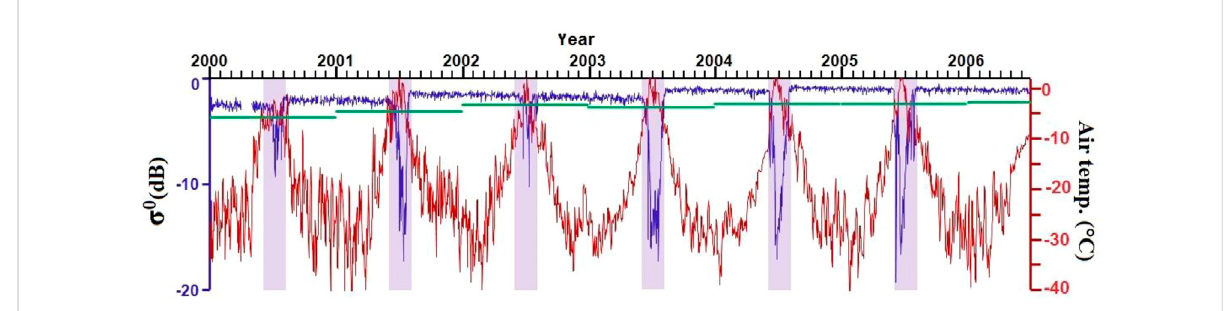
FIGURE 2 AtimeseriesofQuikSCAT-based σ 0(blueline)overlaidondailytemperature(redline)attheAmeryG3AWSsite(70.8919 ° S,69.8725 ° E).Variable yearly melt thresholds computed using the right-hand side of Eq. 1 for July-September for this site are shown by horizontal green bars. When σ 0 drops below the threshold during austral summer, i.e., December- February (magenta boxes), the day is characterized as melting according to Eq 1. The time series begins on 1st July